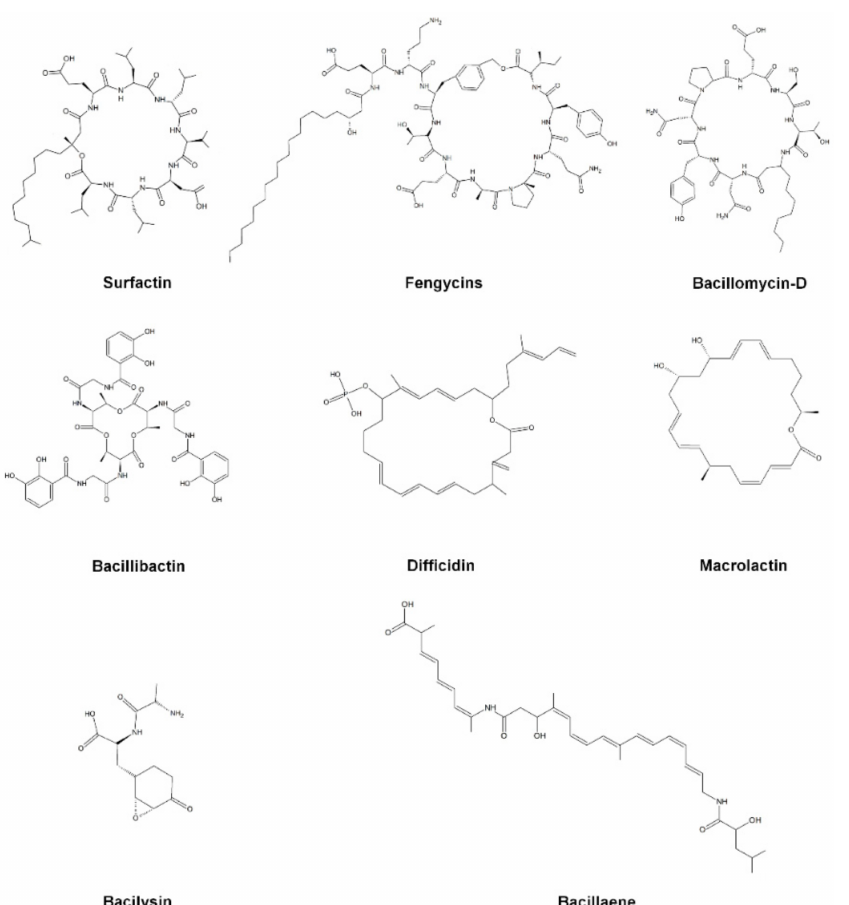
Figure 3. Antimicrobial compounds produced by members of the operational group Bacillus amyloliq-